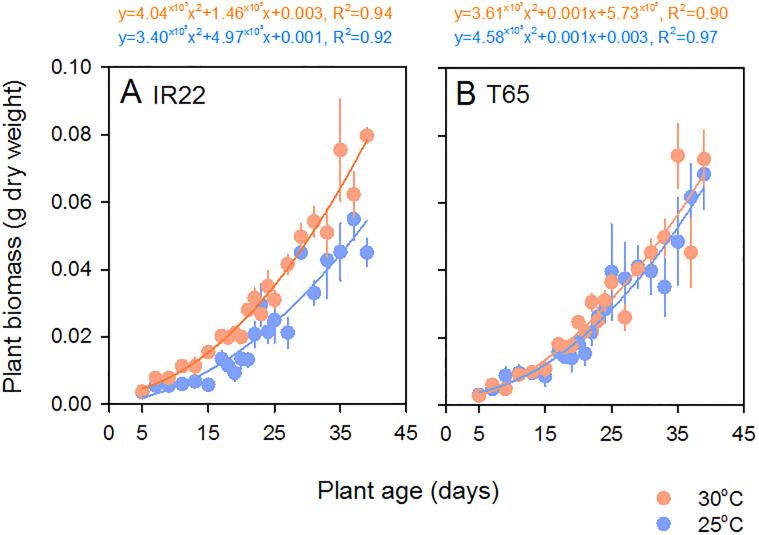
Growth of rice plants at 25°C and 30°C in constant temperature chambers.Points indicate (A) the biomass of IR22 plants at 25°C (blue symbols) and 30°C (orange symbols); and (B) the biomass of T65 plants at 25°C (blue symbols) and 30°C (orange symbols). Bars indicate standard errors (N = 4). Equations are best-fit models for each curve (corresponding colours) with associated R2 values.